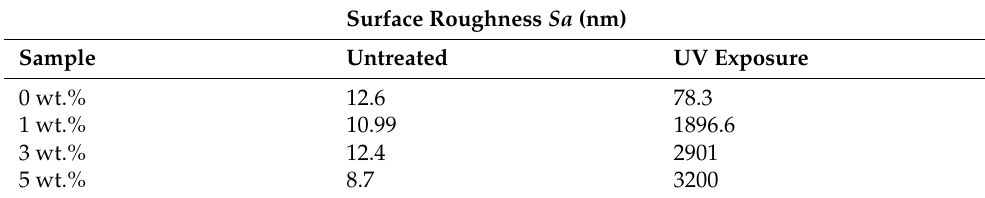
Figure 5. Representative 3D height maps for different samples: ( a ) Untreated samples with 0 wt.% NPs, and UV-treated samples with ( b ) 0 wt.%, ( c ) 1 wt.%, and ( d ) 5 wt.% NP content. Table 3. Surface roughness values of the samples before and after the UV treatment.